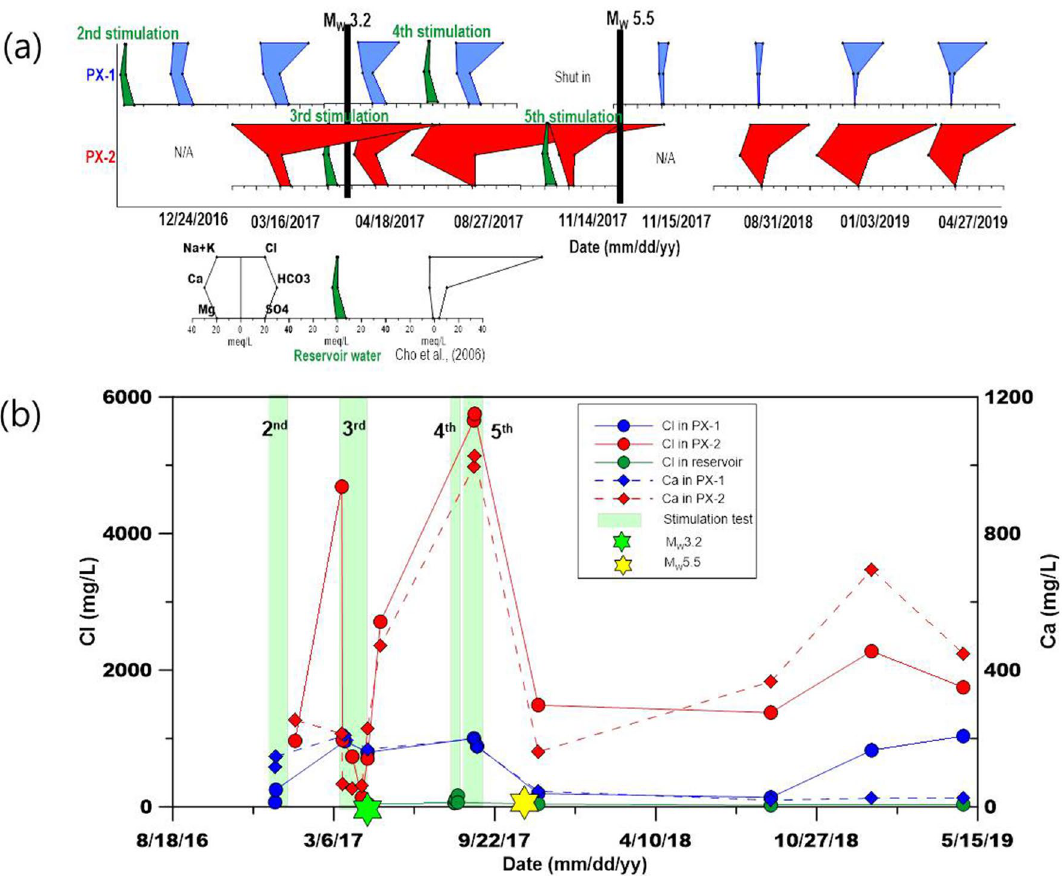
Figure 6. Stiff diagram ( a ); the surface reservoir water used for stimulation was indicated by green stiff diagrams; data collected on 27 August 2017 were modified from Burnside et al. 17 ; and temporal variations of Ca and Cl concentrations in PX-1 and PX-2 after M W 3.2 and M W 5.5 earthquake ( b